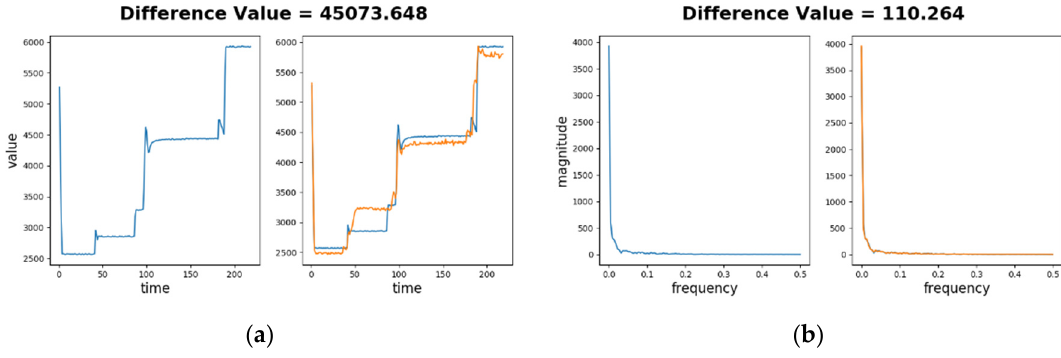
Figure 9. High difference values of an abnormal sequence comparing to its decoded sequence: ( a ) in time series forms; ( b ) in frequency spectra forms.